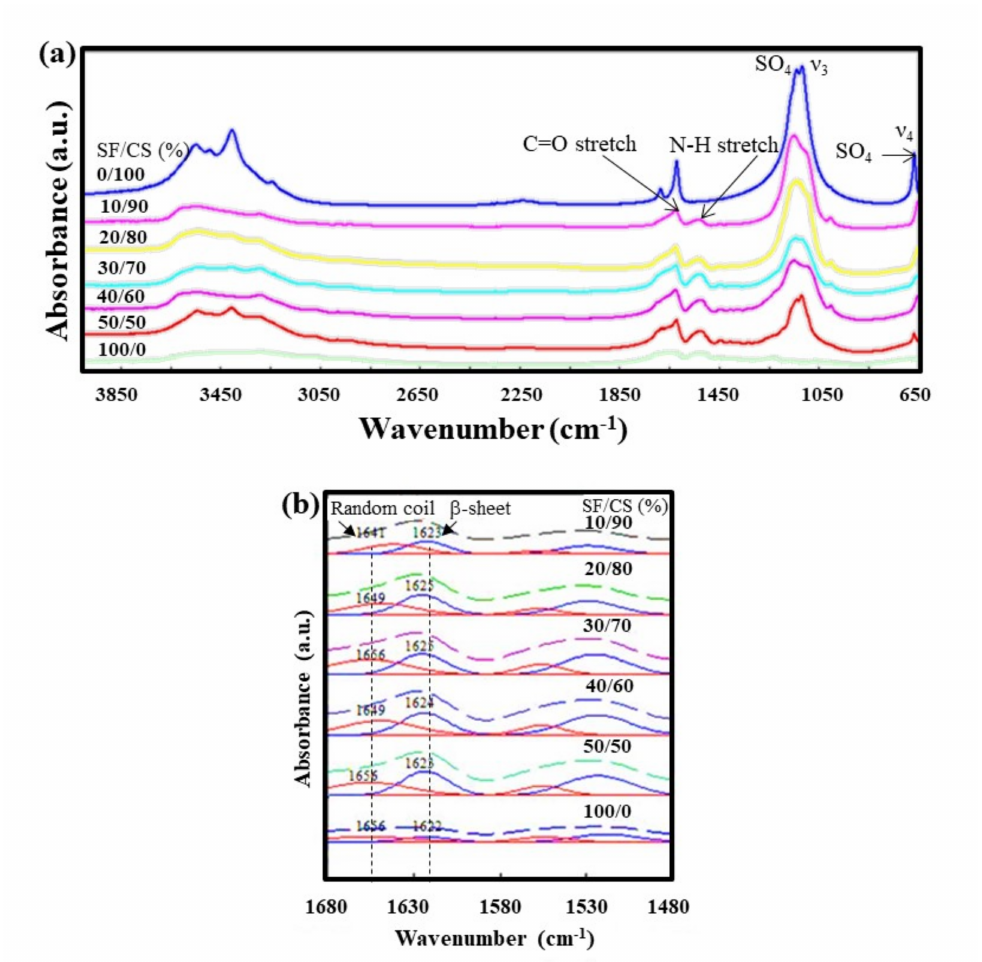
Figure 3. FTIR spectra of ( a ) the SF/CS composite; ( b ) its corresponding de-convoluted peaks showing random coil and β -sheet positions.